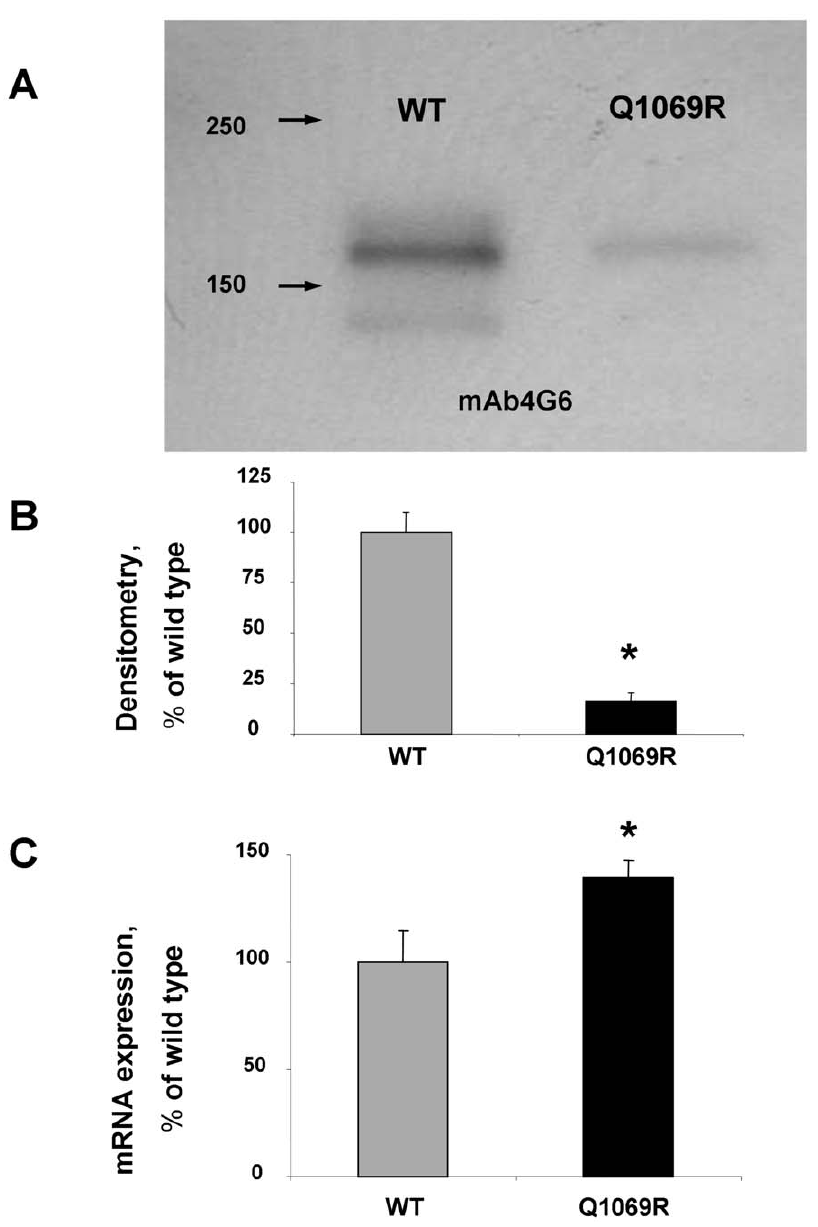
Figure 3. Mutant ACE protein and mRNA quantification. CHO cells were transiently transfected with plasmids coding for wild-type (WT) and mutant (Q1069R) ACE (4 m g of plasmid DNA per 35 mm dish). The lysates of these cells (normalized by equal protein loading of 10 m g per lane) were subjected to SDS-PAGE (4–15% gradient gel) in reducing conditions for Western blotting ( A ) or ACE mRNA quantification ( C ). A . Western blotting was performed with rat mAb (4G6) that recognizes the denatured epitope on the N-domain of human ACE [38]. Proteins transferred on PVDF-Plus membrane were revealed with 2 m g/ml of indicated mAb. Molecular weight markers are shown by arrows on the left of panel A, which is a representative experiment. B . The relative amount of WT and mutant ACE revealed by Western blotting with mAb 4G6 ( A ) was quantified by the image analysis (densitometry) using ImageJ software (NIH). Data are expressed as mean 6 SD of 3 independent experiments. C . Relative mRNA concentrations were calculated from the takeoff point of reactions using manufacturer’s software and normalized to a -tubulin. Data are expressed as mean 6 SD of 3 independent experiments.